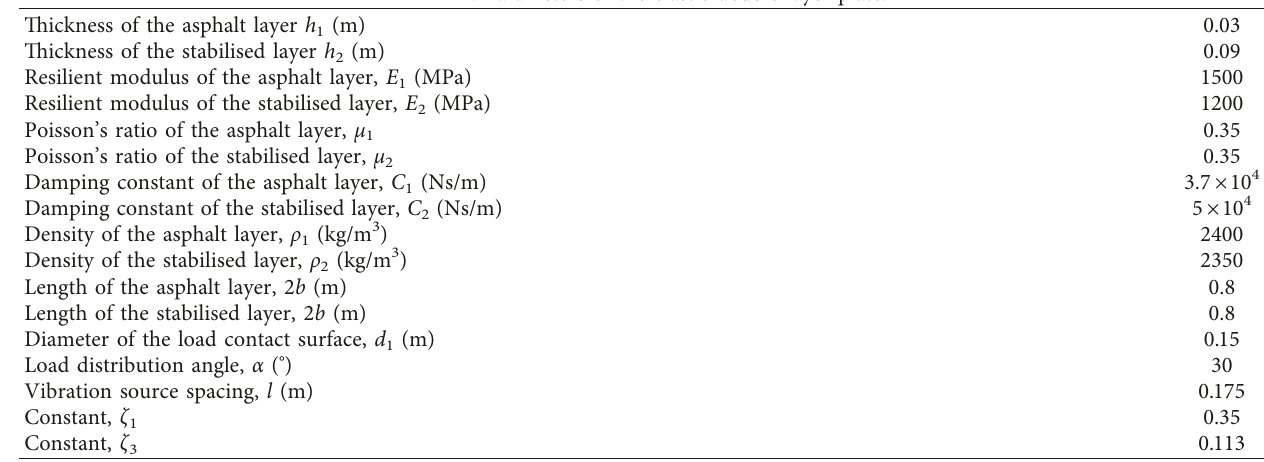
Table 2: Parameters of the elastic double-layer plate.